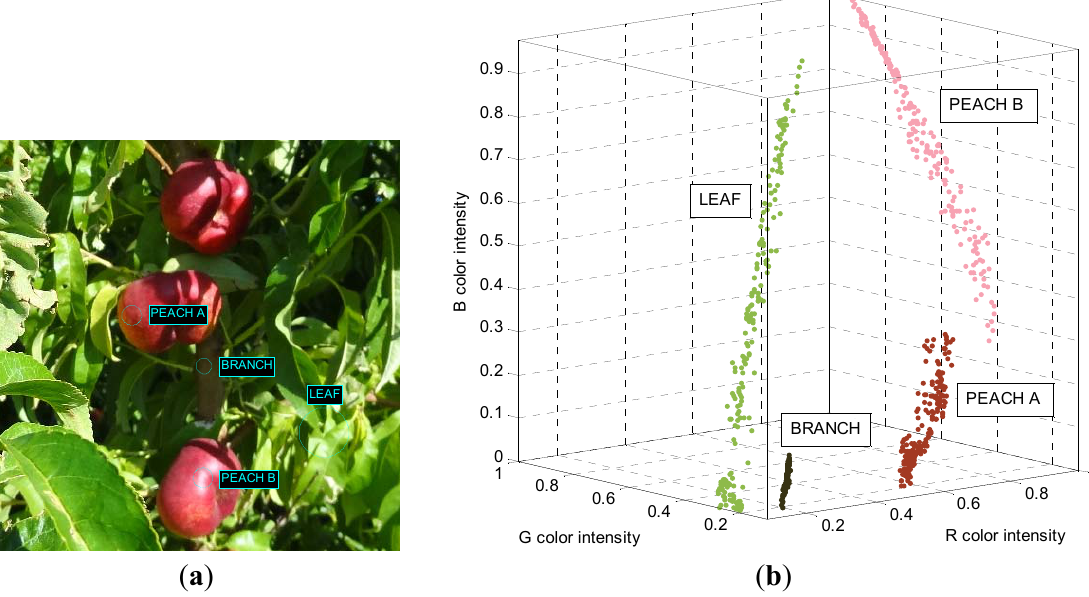
representation of the RGB color intensity distribution of the pixels selected in the RGB vector color space ( b ).